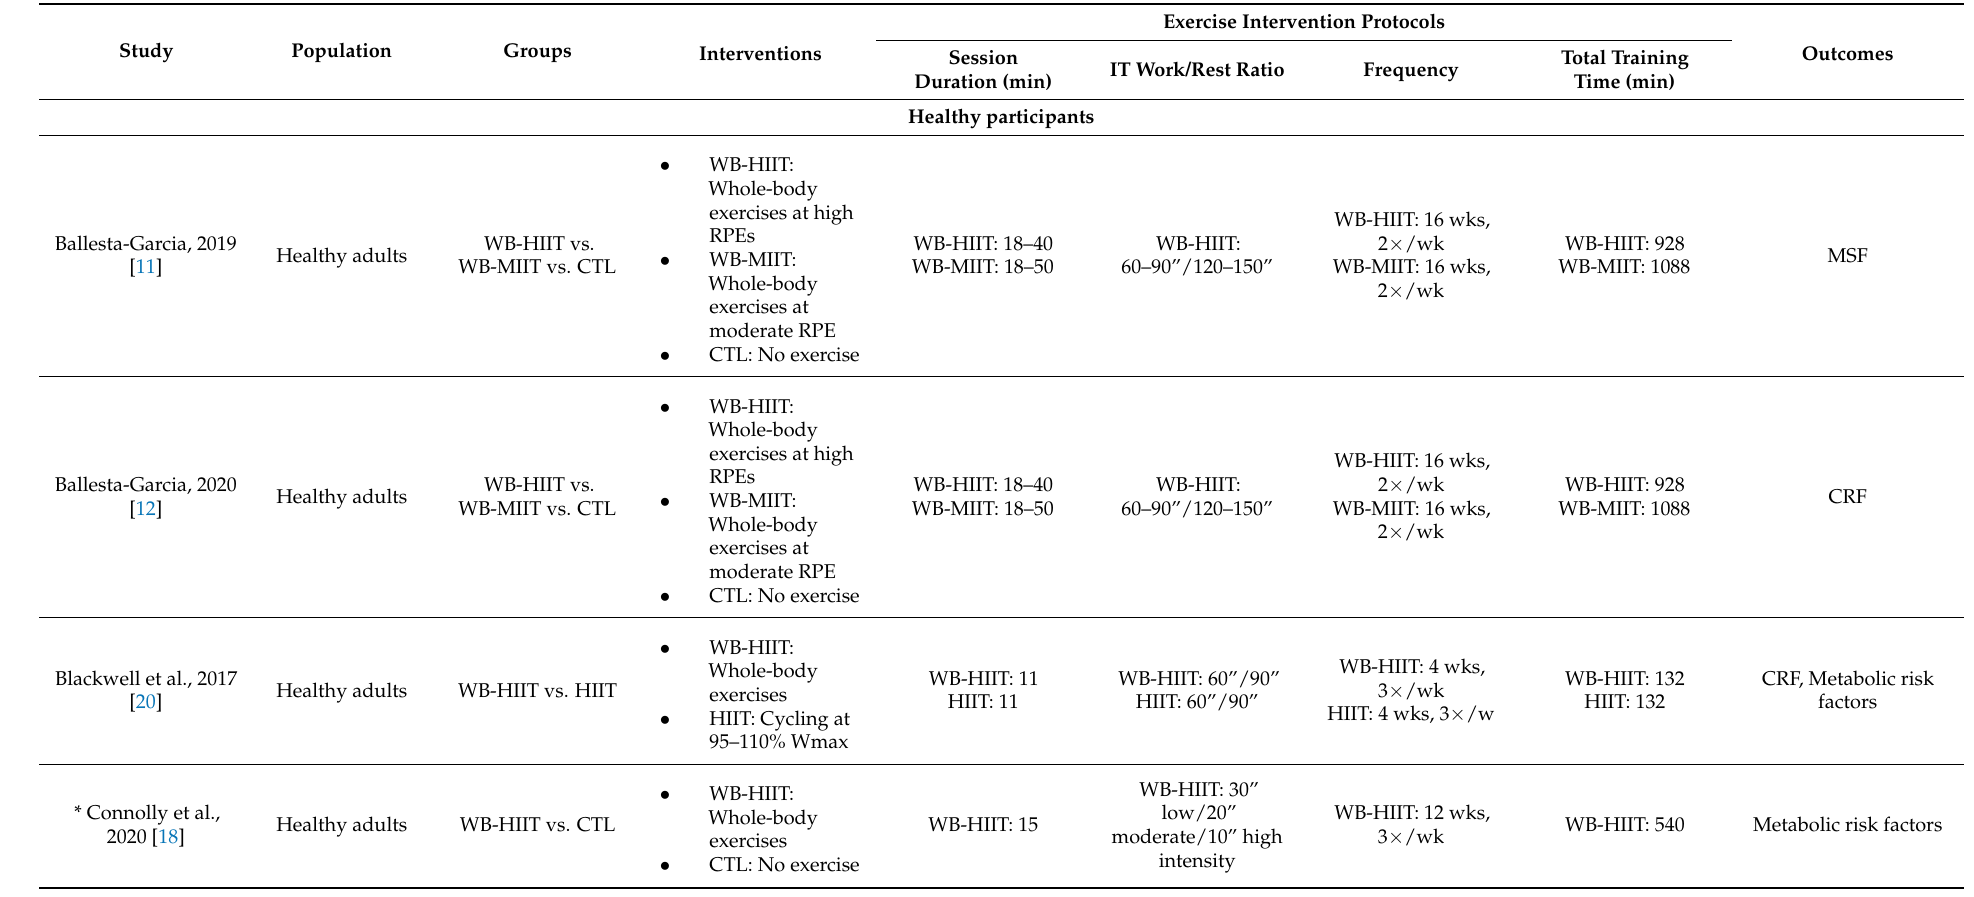
Table 1. Characteristics of the included